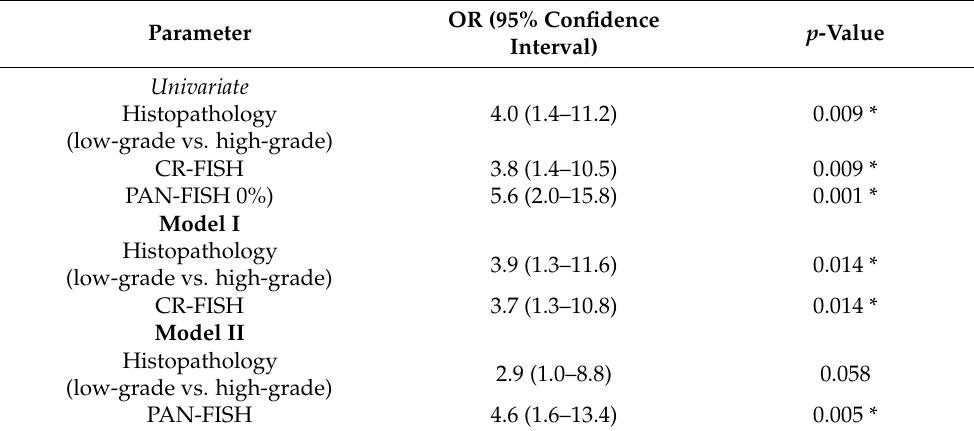
Table 3. Odds ratios of parameters predicting malignant progression.